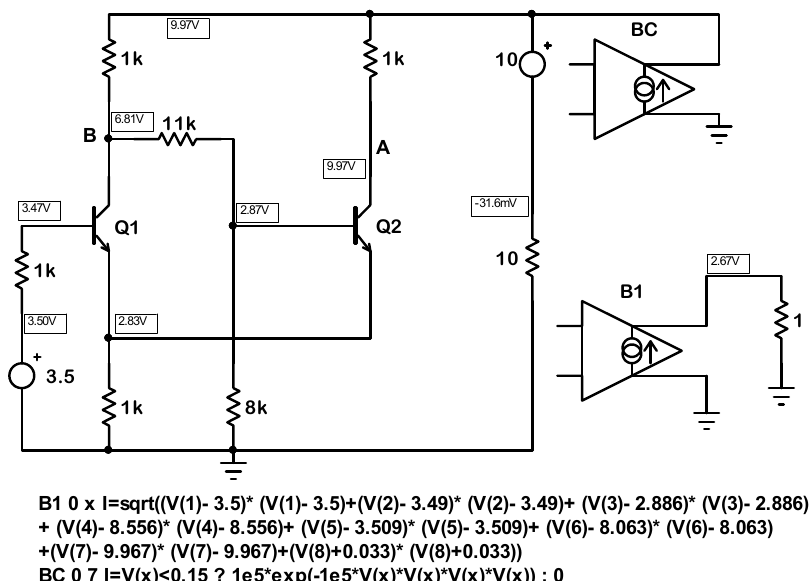
Figure 3. Modified, according to the idea of deflation, circuit shown in Figure 1 and the results corresponding to the second DC solution ( k =